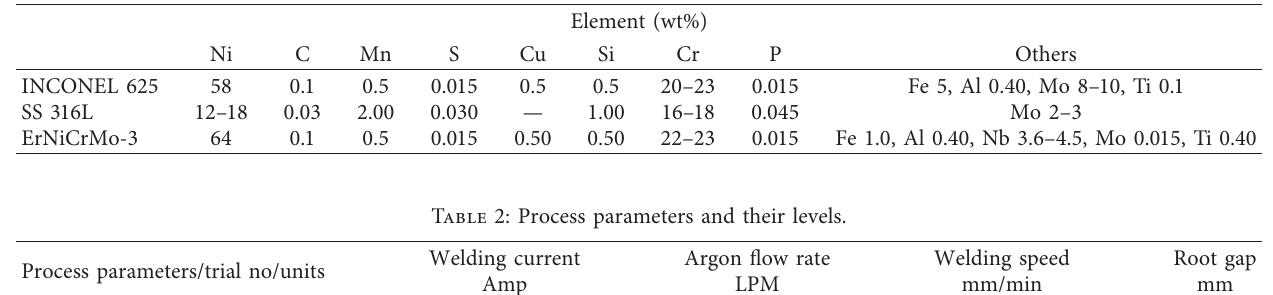
Table 1: Parent materials and filler wire chemical composition.